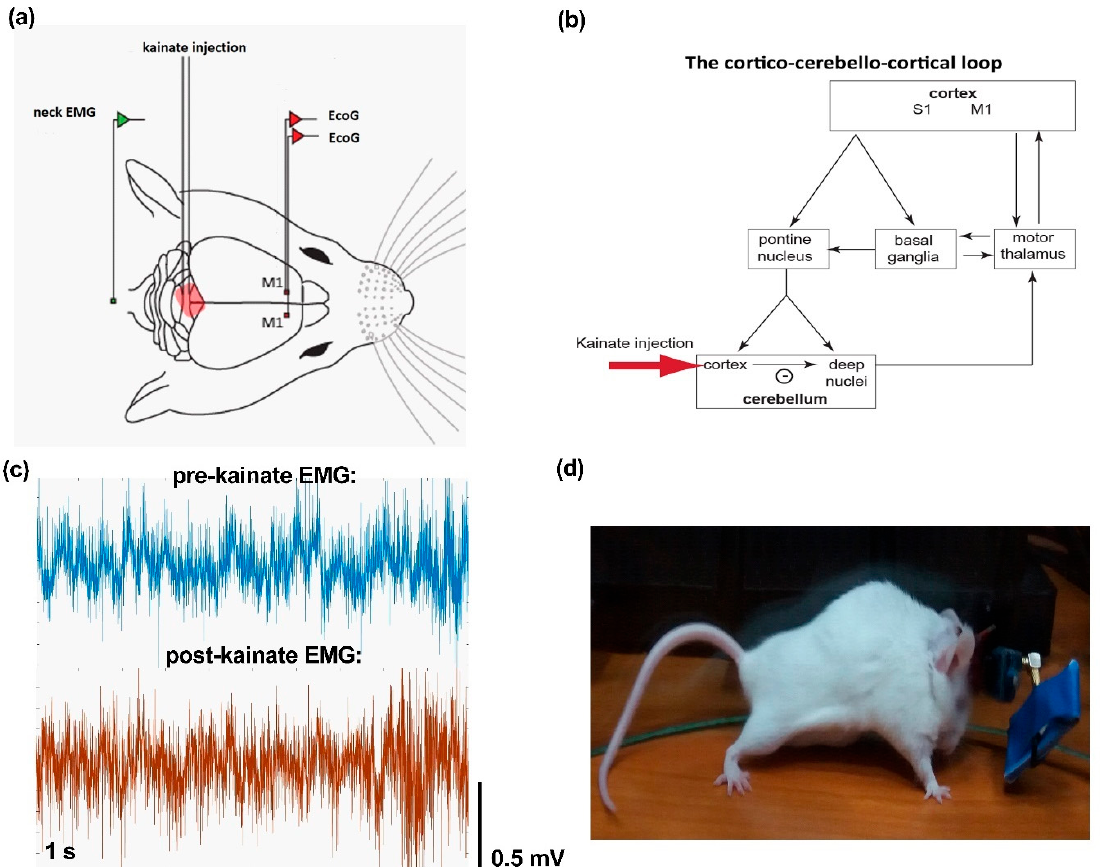
Figure 1. ( a ) Schematic representation of the experiment setup (adaptation after Georgescu et al. [15]); placement of the electrodes for the left and right primary motor cortices (M1) electrocorticograms (ECoGs). ( b ) Diagram of the cortico-cerebellar-cortico-circuit (S1 is an acronym for sensorimotor cortex) and indication of the site of kainate application. ( c ) Example of electromyogram (EMG) traces before and after the kainate cerebellar vermis administration. ( d ) The phenotypic effect of the kainate administration with intense truncal muscle contractions.